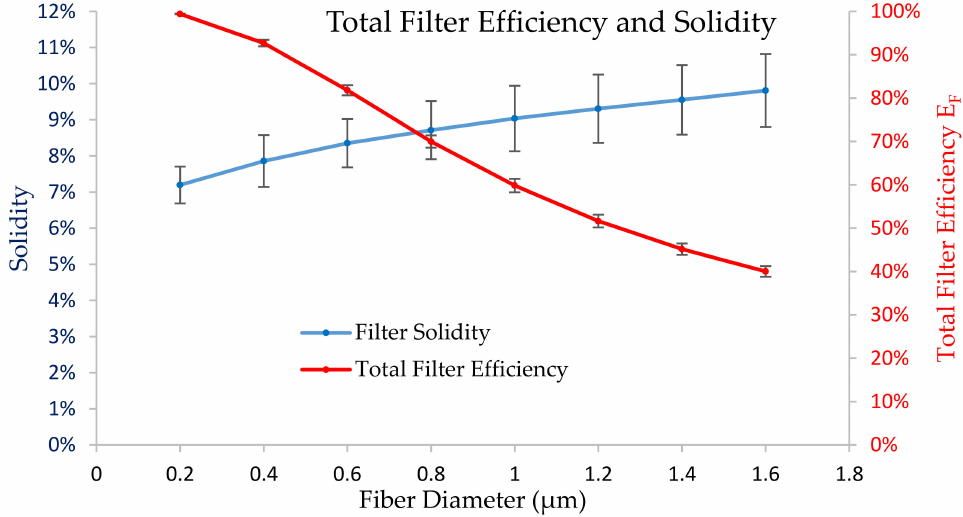
Figure 13. Sensitivity analysis for total filter efficiency and filter solidity. The data represents mean values of samples drawn at each diameter size. Error bars represent a 95% confidence